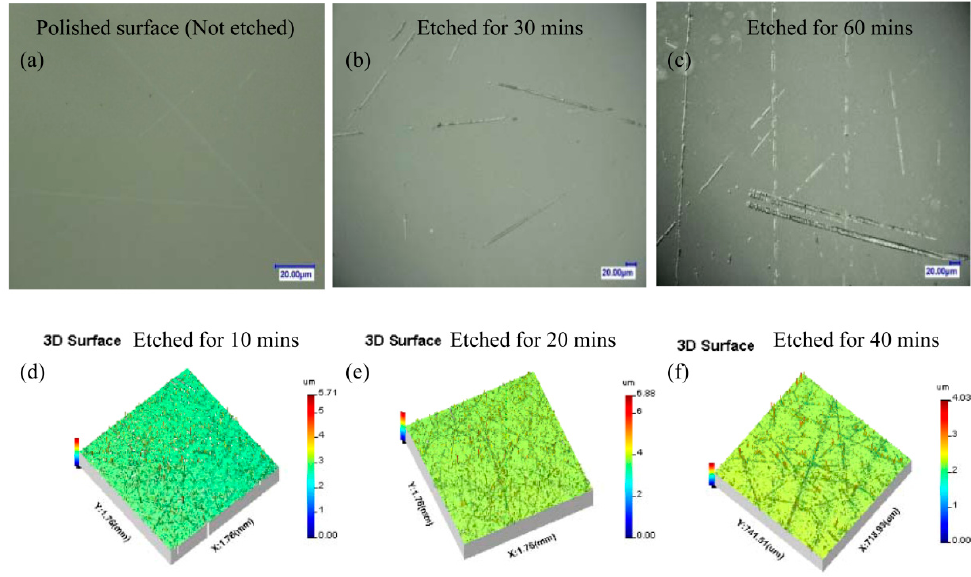
Figure 12. The evolution of surface morphology of etched fused silica under various etching periods. The etched surfaces are tested with a 3D stereo microscope for etching periods of ( a ) 0 min; ( b ) 30 min and ( c ) 60 min The surface morphologies of etched surfaces are also tested with white light interferometer for etching periods of ( d ) 10 min; ( e ) 20 min and ( f ) 40 min.